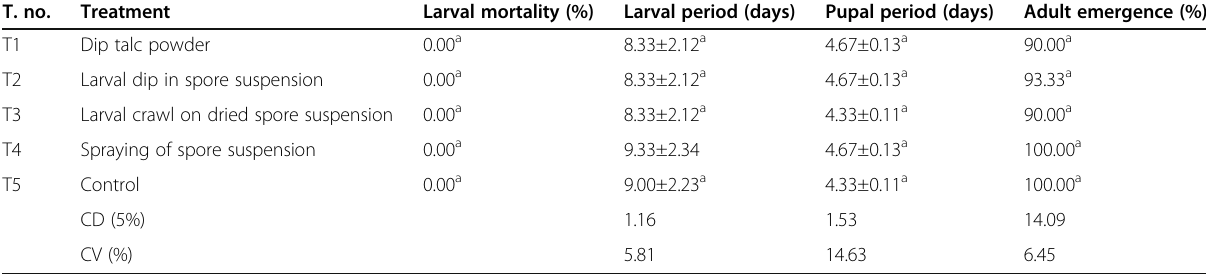
Table 8 Effect of Lecanicillium lecanii on some biological parameters of Stethorus gilvifrons T.